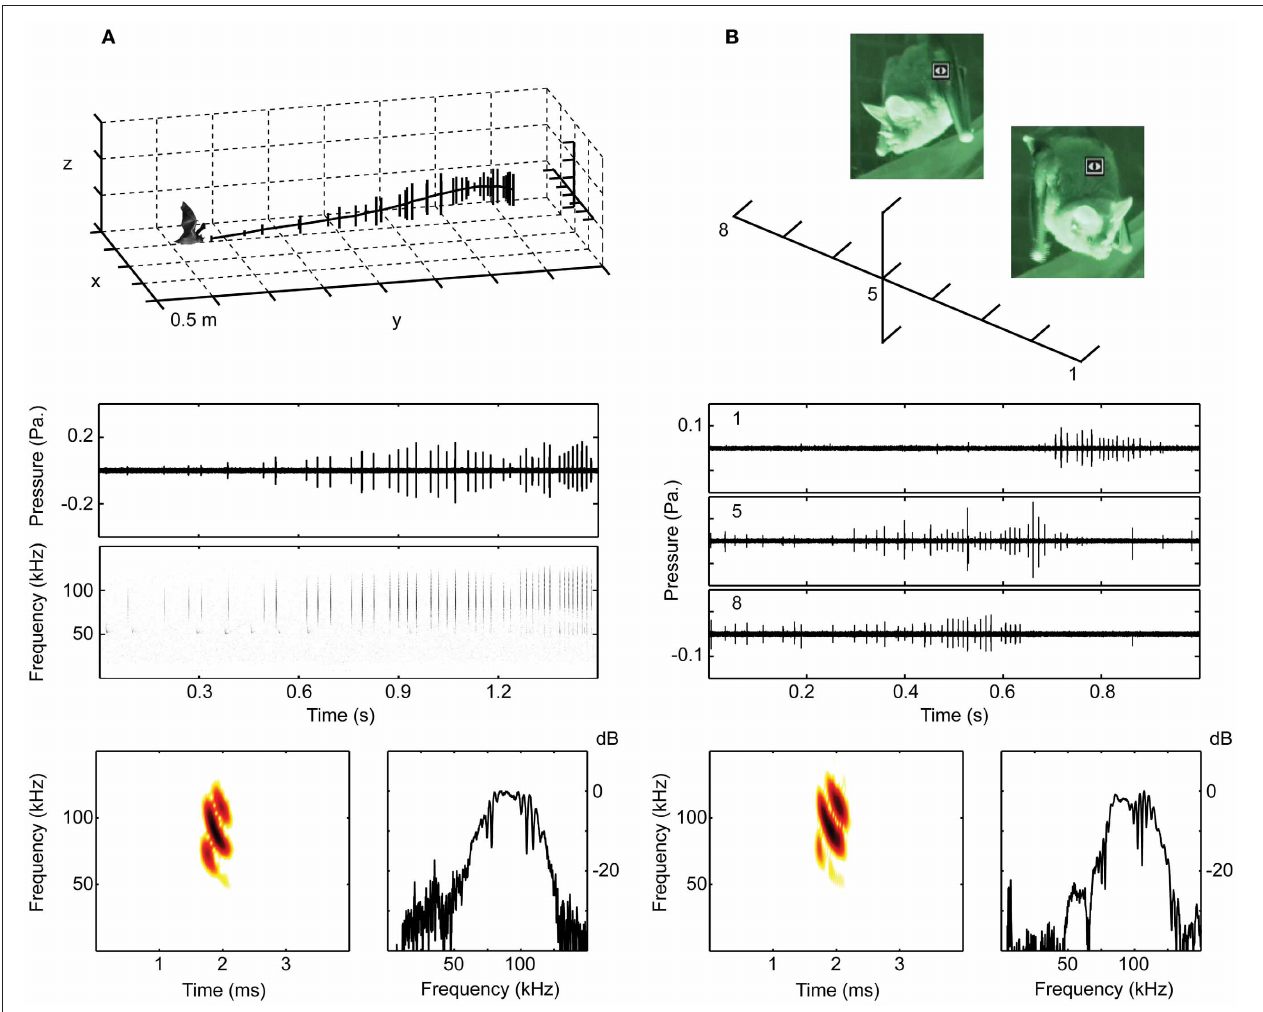
FIGURE 2 | The bats were recorded with microphone arrays when hanging from a perch or when flying. (A) Shows the set-up in 2012 with 11 microphones in a cross-shaped array, 7 horizontal and 3 above and 1 below the center microphone. The middle panel shows oscillograms and spectrograms of the echolocation calls emitted in the flight illustrated in the upper panel, where each vertical line is a call. The lower panel shows a spectrogram and a spectrum of one of the calls from the same sequence. (B) Shows a recording from 2008 of a perching bat. The 10 microphone array